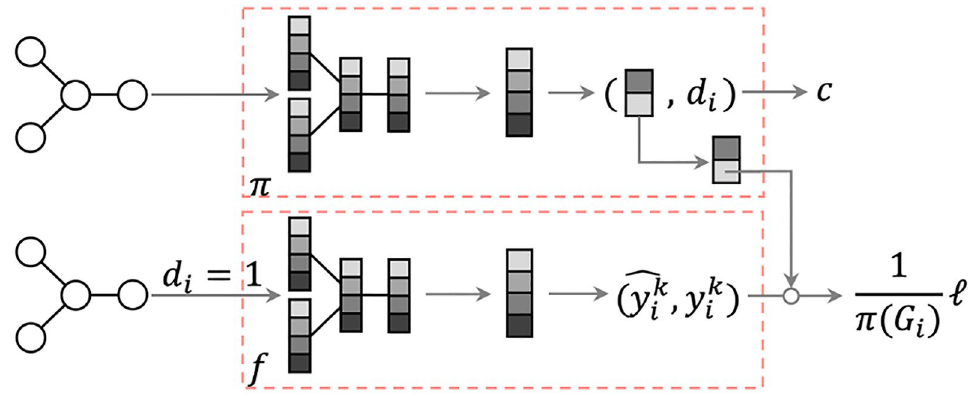
Figure 6. Architecture of the two-step IPS